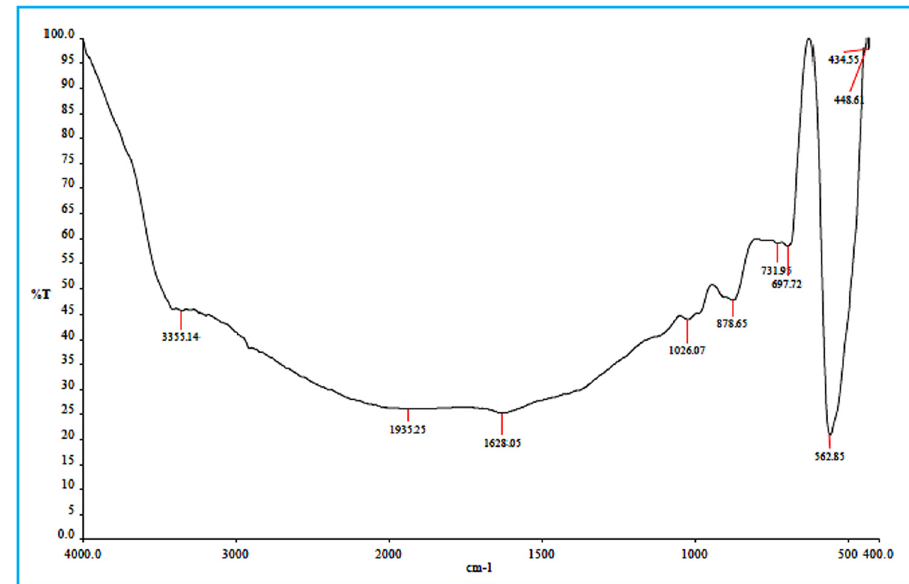
Figure 7: FTIR spectra of C. baccifera synthesized ZnNPs.